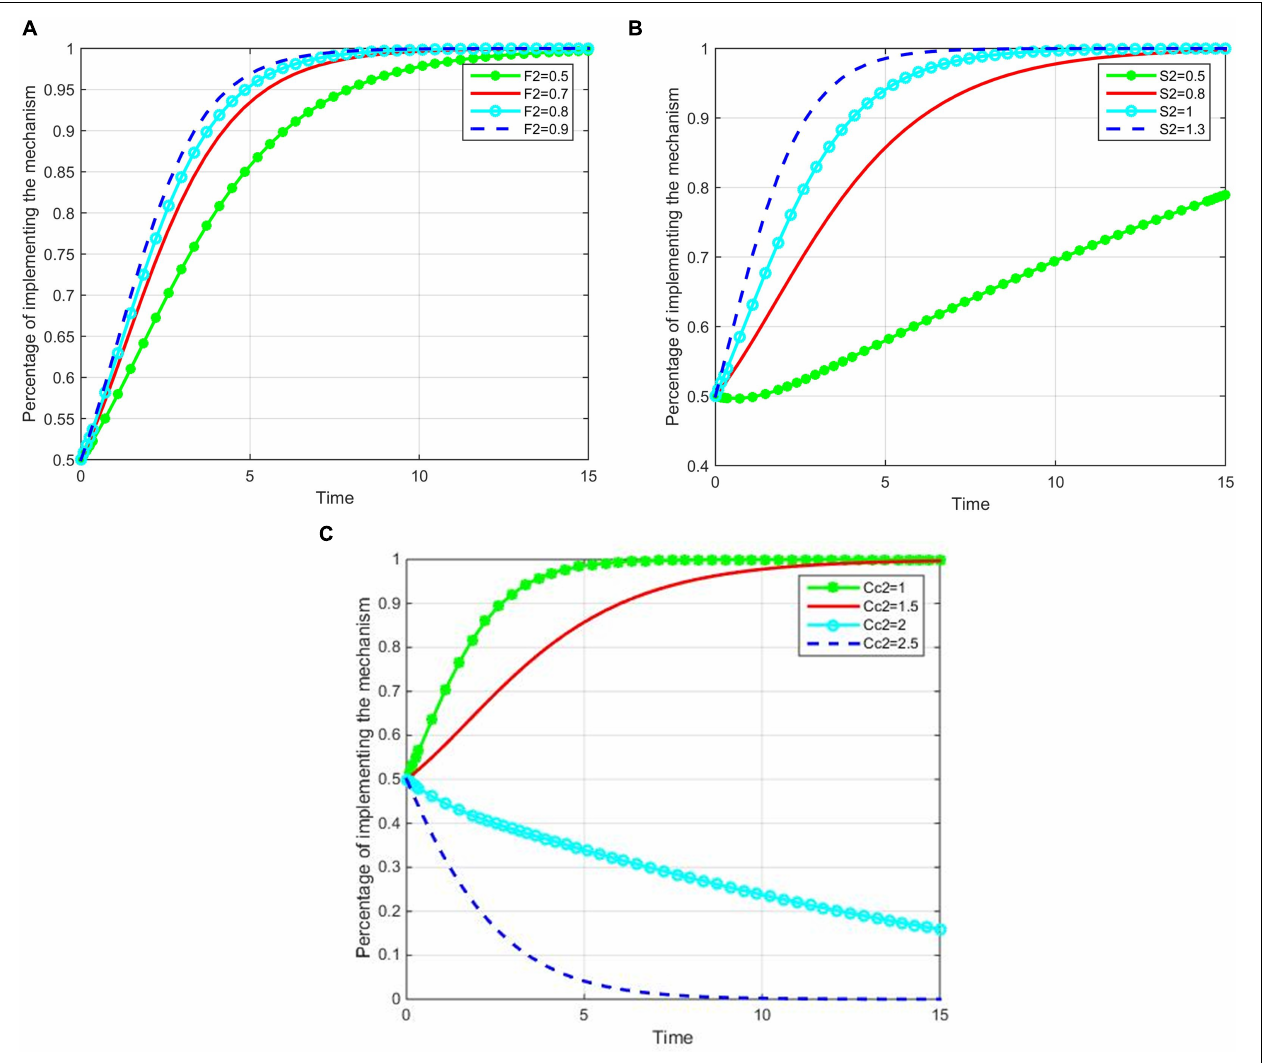
FIGURE 5 | The impact of fine, subsidy and cost on implementing the second mechanism. (A) The impact of fine on implementing the second mechanism. (B) The impact of subsidy on implementing the second mechanism. (C) The impact of cost on implementing the second